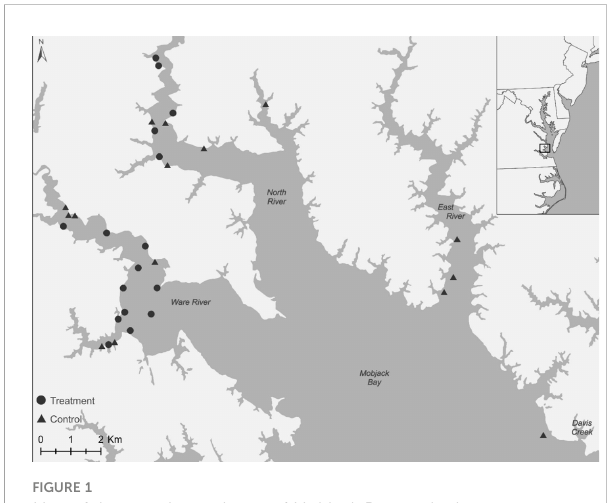
FIGURE 1 Map of the experimental area of Mobjack Bay on the lower eastern region of Chesapeake Bay, VA, USA. The locations of the control group (N = 15) represented by black triangles and the food addition group (N = 16) represented by black